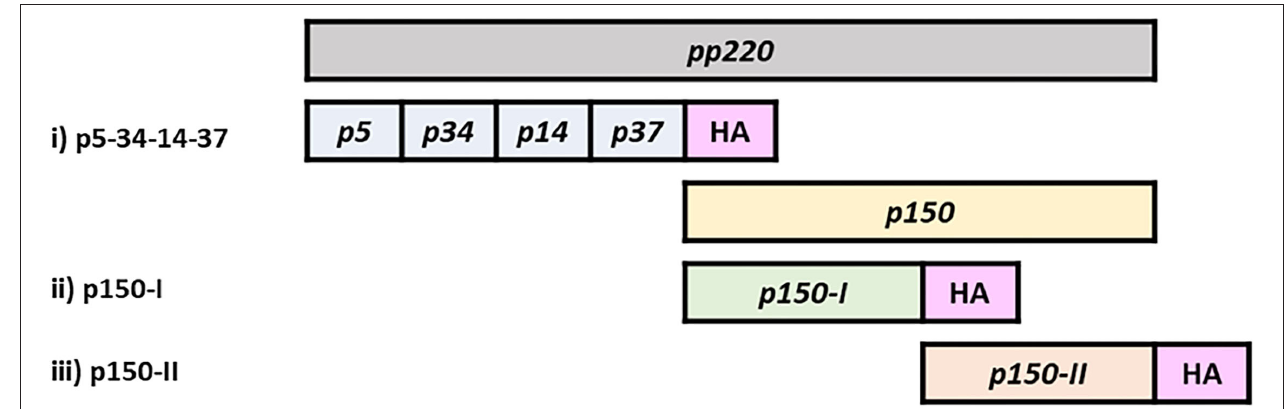
FIGURE 1 | ASFV pp220 expression constructs. Illustration of synthetic genes encoding ASFV pp220 polyprotein. p5-34-14-37 constitute genes encoding structural proteins p5, p34, p14, and p37. Due to its large size, the sequence encoding p150 was split into two genes: p150-I; and p150-II. Synthetic genes had an HA tag added in-frame at the 3’ end for tracking protein expression.